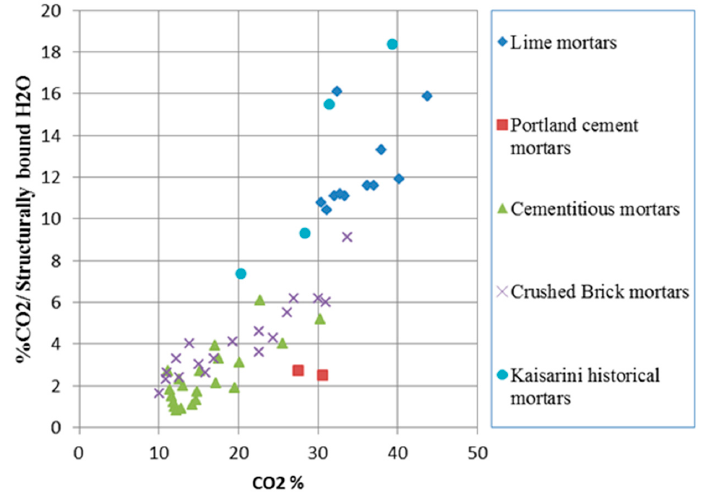
Figure 7. Grouping of the Kaisariani mortars according to thermal analysis results.